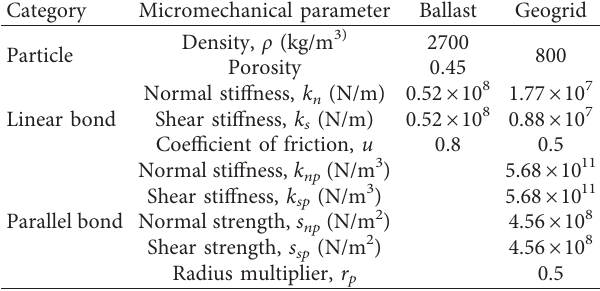
Table 1: Micromechanical parameter of the DEM model [15]. Category Micromechanical parameter Ballast Geogrid Particle